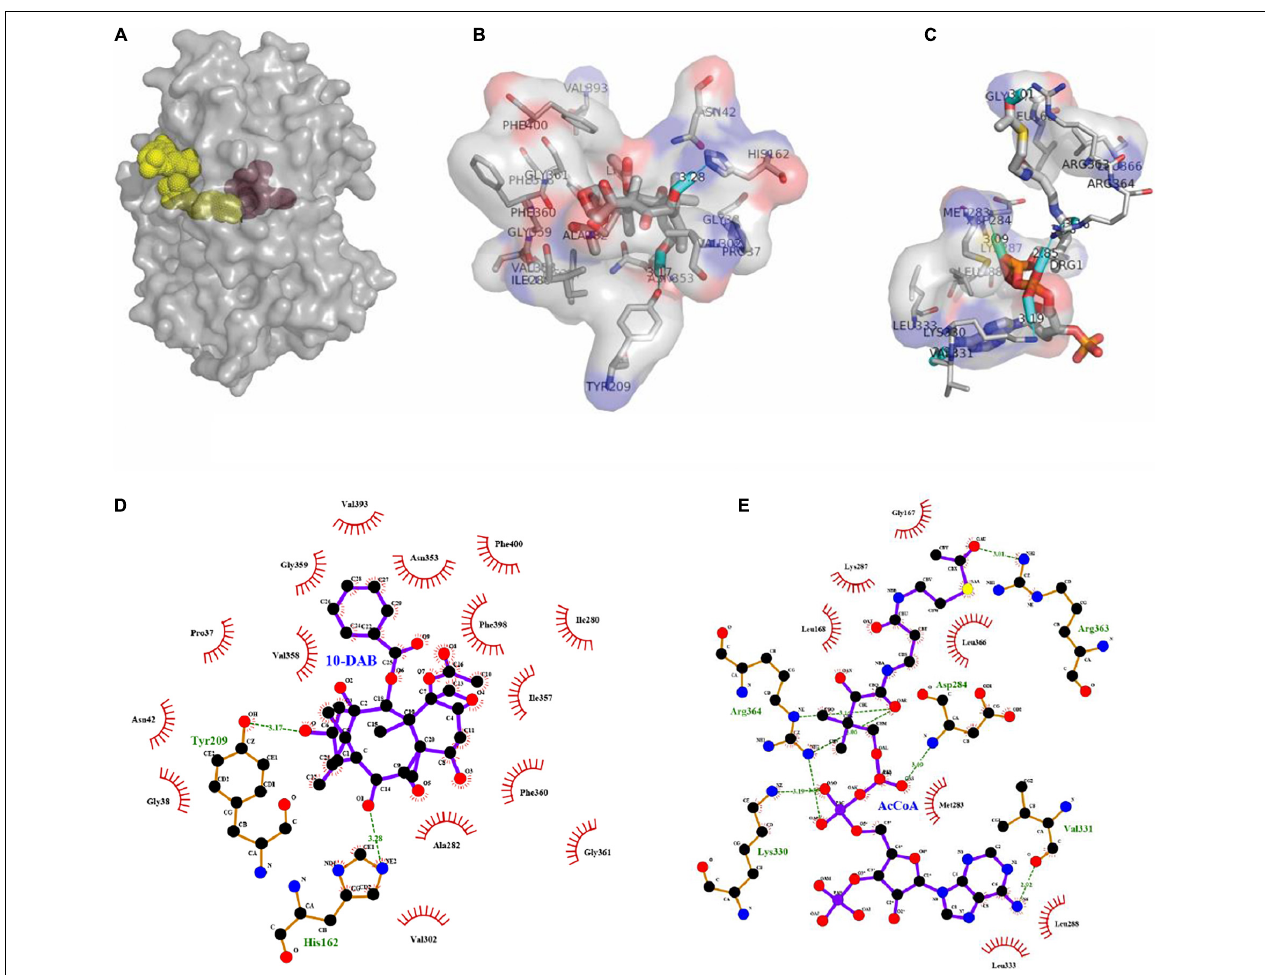
FIGURE 4 | Molecular docking results of DBAT S198V and two substrates. The complex was named S189V_10-DAB_AcCoA. (A) Panoramic conformation of S189V_10-DAB_AcCoA. (B) Interaction between 10-DAB and DBAT S189V in 3D-model. (C) Interaction between acetyl-CoA and DBAT S189V in 3D-model. (D) The hydrogen bonds were shown as green dotted lines between 10-DAB and DBAT S189V . (E) The hydrogen bonds were shown as green dotted lines between acetyl-CoA and DBAT S189V .